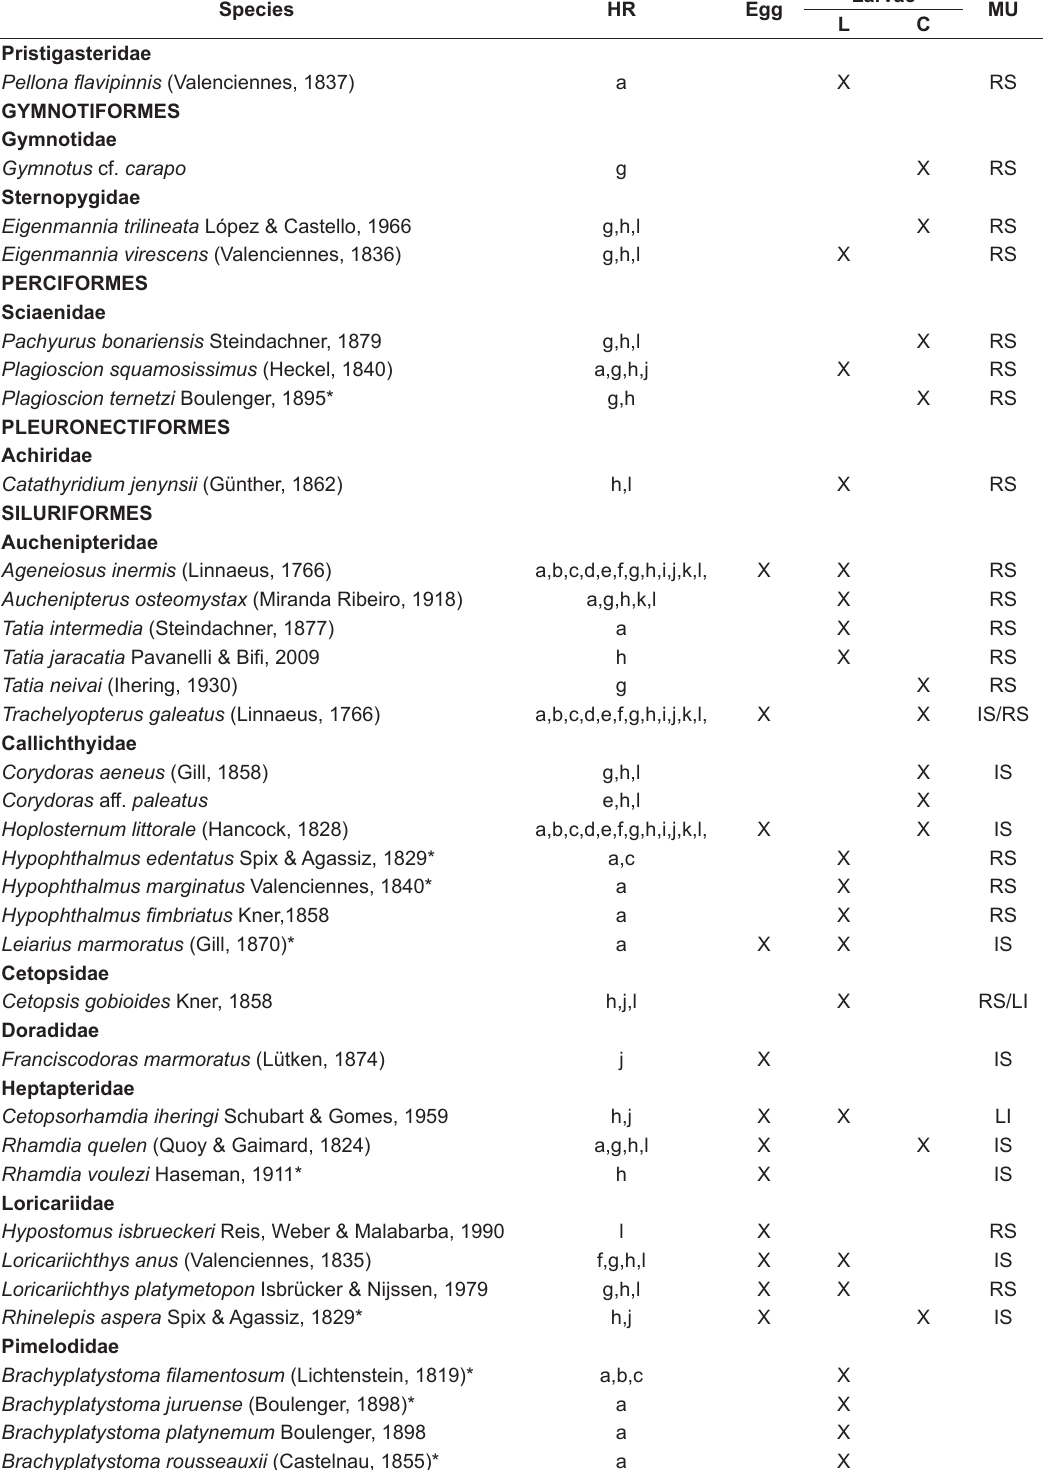
HR: Hydrographic region of origin, a = Amazon, b = Western Northeast Atlantic, c = Eastern Northeast Atlantic, d = East Atlantic, e = Southeast Atlantic, f = South Atlantic, g = Paraguay, h = Paraná, i = Parnaíba, j = São Francisco, k = Tocantins-Araguaia and i = Uruguay; Larvae, I = Incomplete, without all larval stages and C = Complete, with all larval stages; MU = Methodology used to obtain the collection, RS = regressive series, IS = induced spawning and LI = live ichthyoplankton *commercial